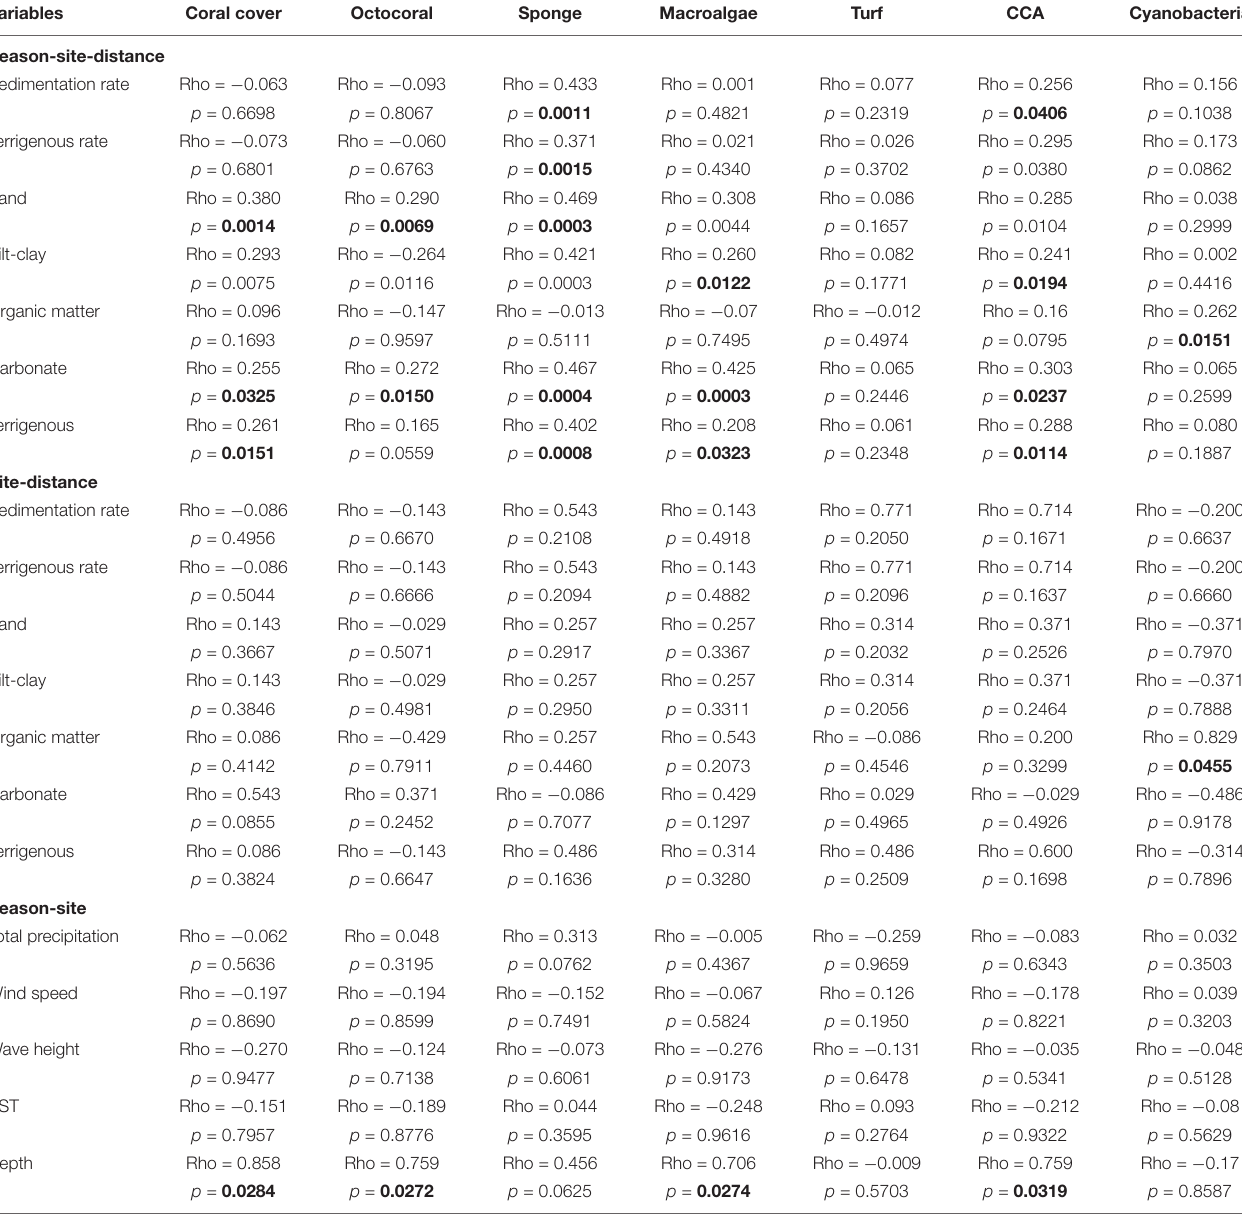
TABLE 4 | Relate (Spearman rank) correlation of benthic components and environmental